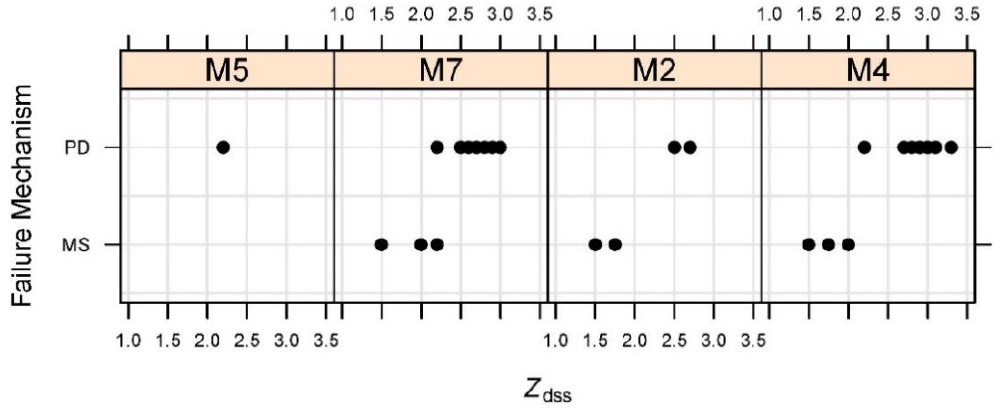
Figure 9. Relationship between the failure mechanisms and the downstream slope ( Z dss ). The acronyms PD and MS refer to ‘particle dragging’ and ‘mass sliding’, respectively.